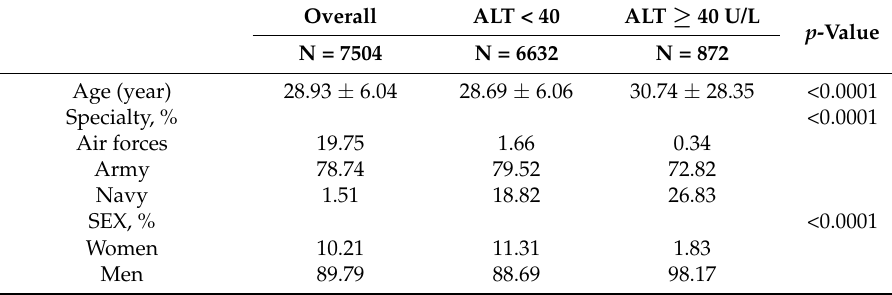
Table 1. Baseline characteristics of the study cohort based on serum ALT